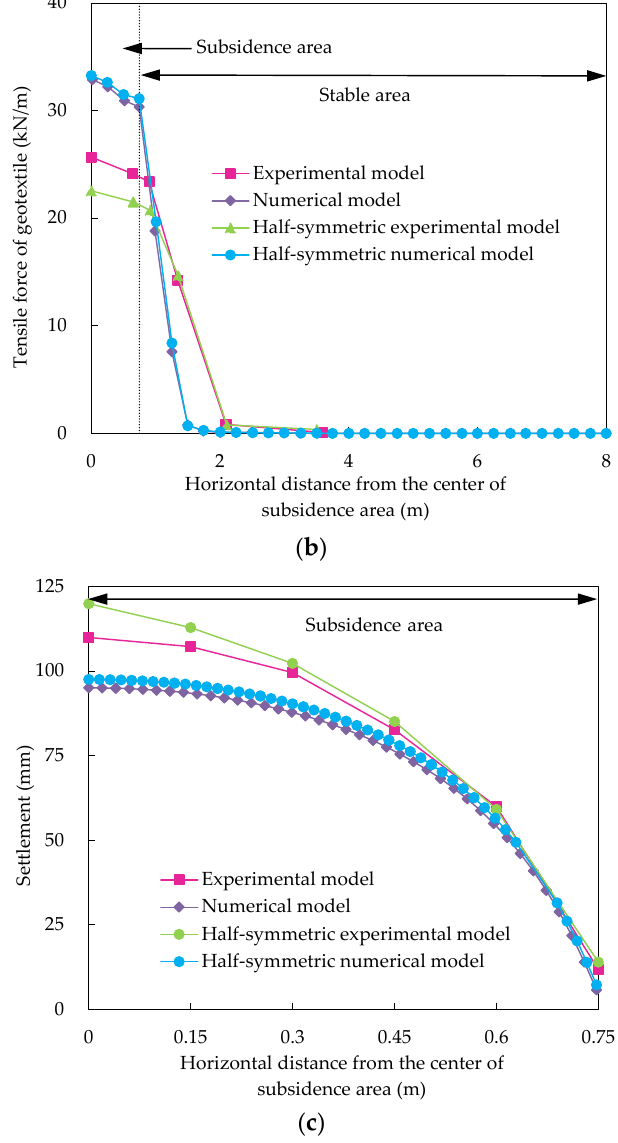
Figure 4. Comparison between the model test and the numerical model results of the half-symmetric model and the full-section ( L = 2.0 B ) at the final state of a subgrade collapse: ( a ) comparison of the soil pressure curves below the geotextile; ( b ) comparison of the tensile force curves of the geotextile; ( c ) Settlement amount of the subsidence